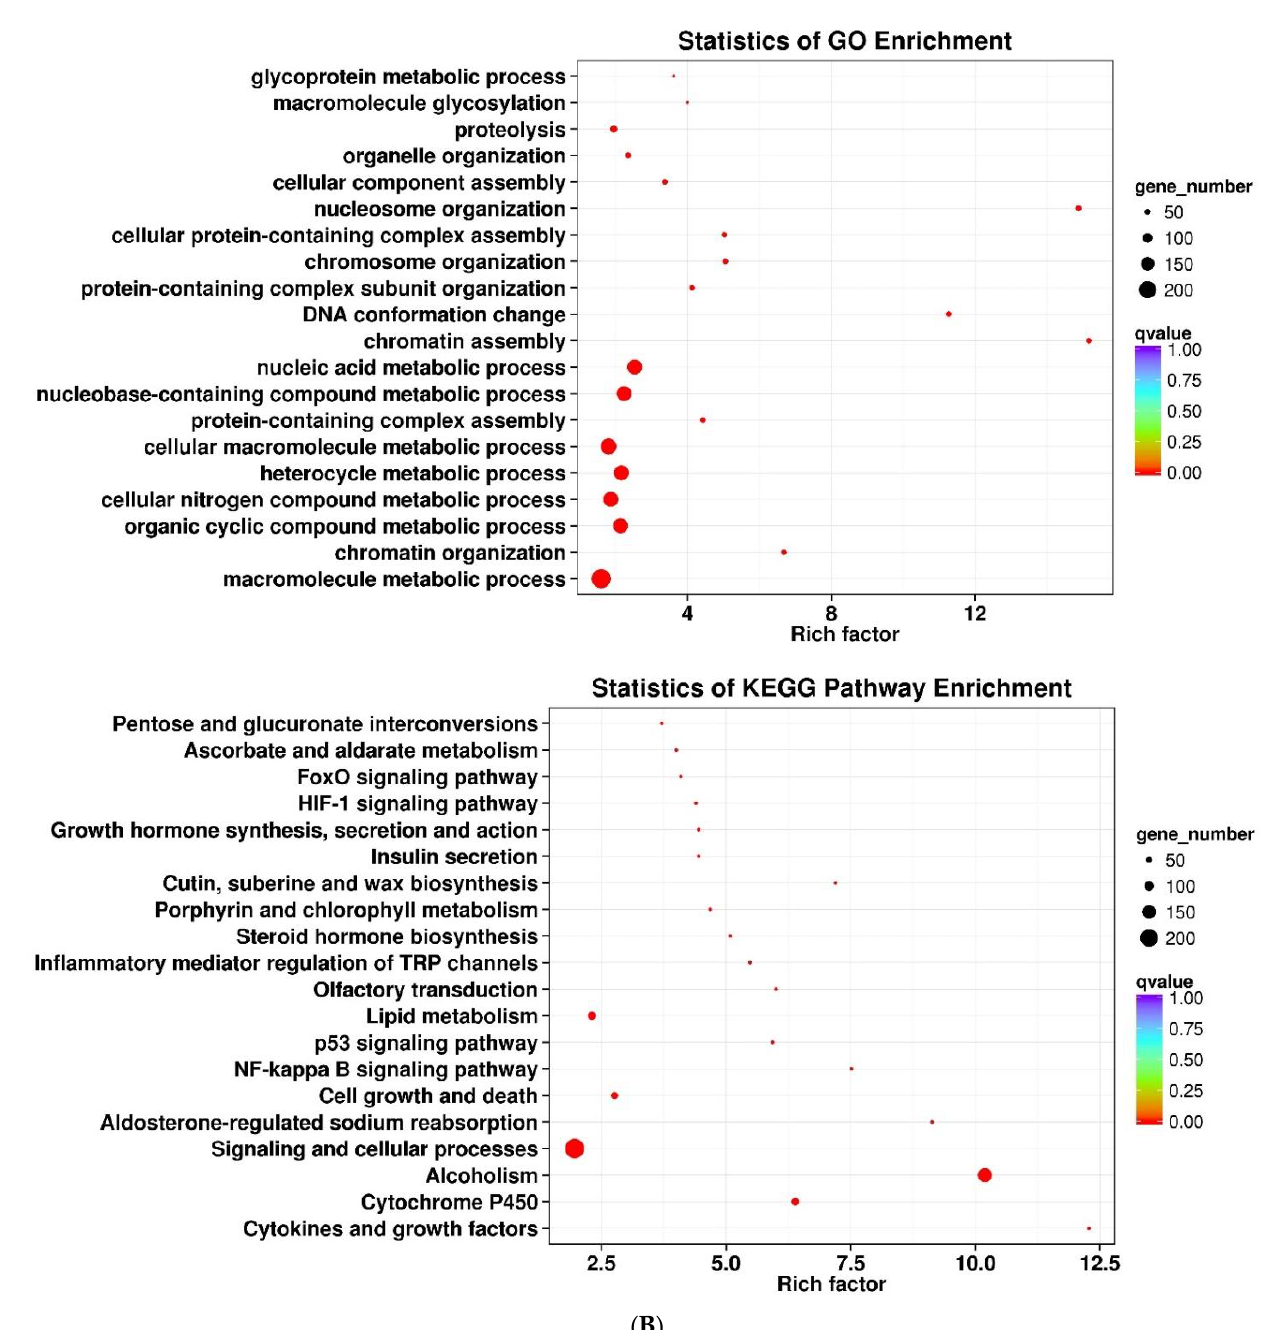
Figure 2. Phylogenetic and gene family analysis of H. assimilis. ( A ) Time-calibrated phylogeny of the fifteen butterfly species based on single-copy orthologous genes. Numbers on the bar charts indicate the numbers of gene families that experienced expansion (red) or contraction (blue); the number beside each node denotes the estimated divergence time (millions of years ago). Numbers in parentheses are SH-aLRT support (%)/ultrafast bootstrap support (%). The red star represents the common nodes of the cluster leading to four saprophagous species ( V. tameamea , V. atalanta , M. cinxia , and H. assimilis ). ( B ) GO and KEGG enrichment analysis of expanded gene families was visualized as a scatter plot. The vertical axis represents the path name, and the horizontal axis represents the gene ratio. The bubble size indicates the gene number, and the color corresponds to different q-value ranges.